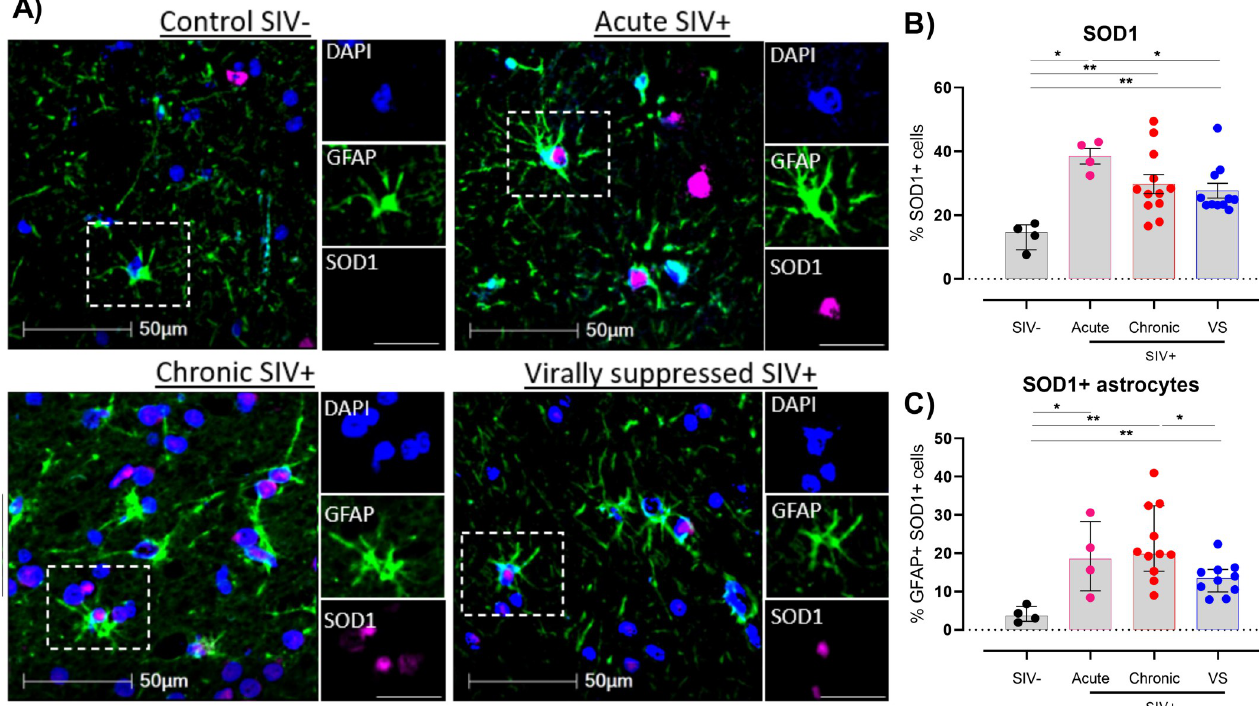
Fig 3. SIV infection enhances SOD1 production in the frontal cortex in the brain. (A) Representative images of frontal cortex tissue of SIV infected (acute, chronic or virally suppressed [VS]) or uninfected controls was stained using fluorescent multiplex immunohistochemistry to detect GFAP (astrocyte), SOD1 and DAPI (4 0 ,6-diamidino-2-phenylindole). Images shown at x30 magnification; scale bars: 50 μ m and 25 μ m (single channel inset). (B) Frequency of total SOD1+ cells or (C) SOD1+ astrocytes in frontal tissue. Comparisons made using Mann-Whitney U test, * P < 0.05, ** P < 0.01, *** P < 0.001). Median and interquartile ranges